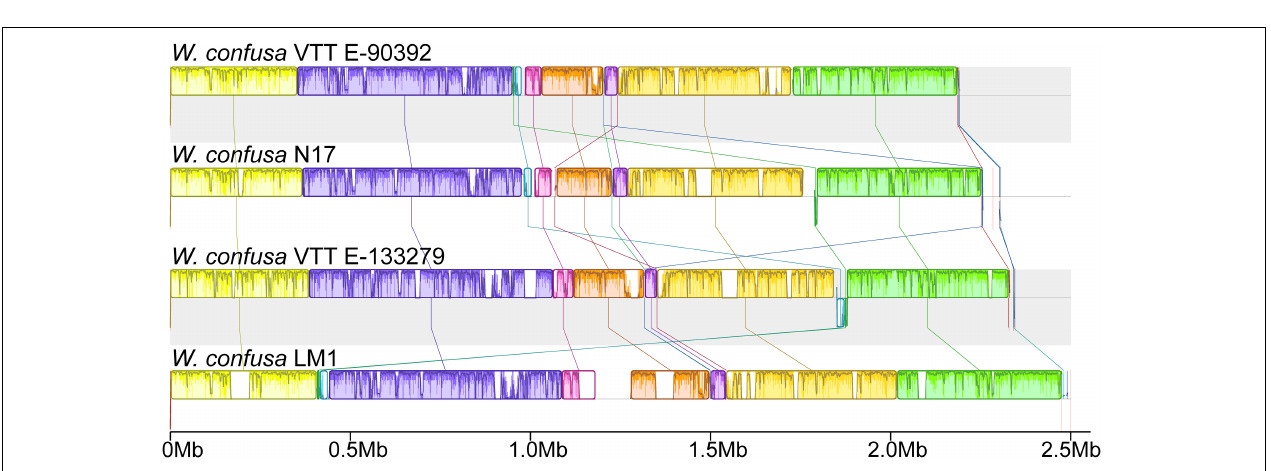
FIGURE 3 | Evolutionary relationships of 39 W. confusa strains. (A) Heatmap of percentage ANI value among different W. confusa strains; the strain on the vertical axis serves as the reference. (B) Evolutionary tree analysis based on the protein-coding genes.